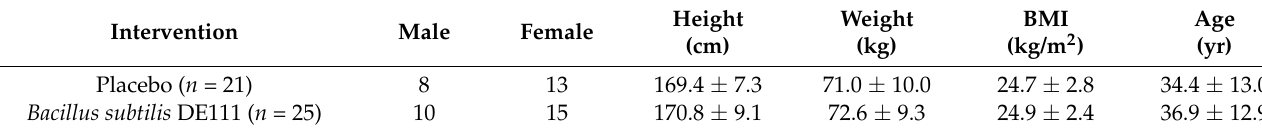
Table 1. Participant Baseline Characteristics.